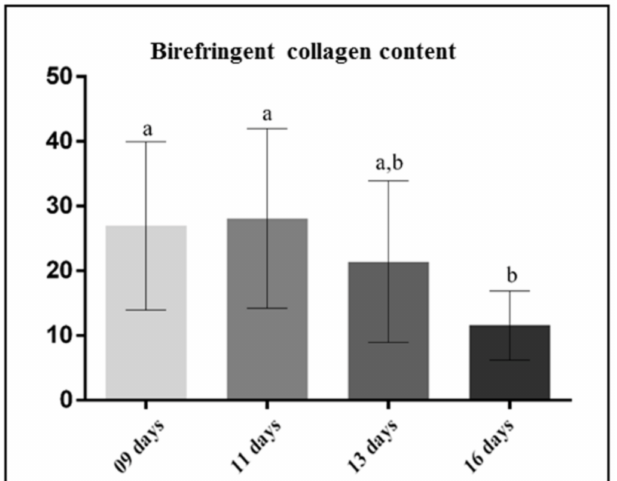
Figure 3. Birefringent collagen content (percentage) in the lamina propria of the eruptive pathway from 9-, 11-, 13-, and 16-day-old rats. Significant reduction in the collagen content is observed in 16-day-old rats in comparison to 9- and 11-day-old rats. Significant difference is not observed between 13- and 16-day-old rats. One way ANOVA and the Tukey post-hoc test ( p ≤ 0.05). Statistically significant difference among groups is indicated by different